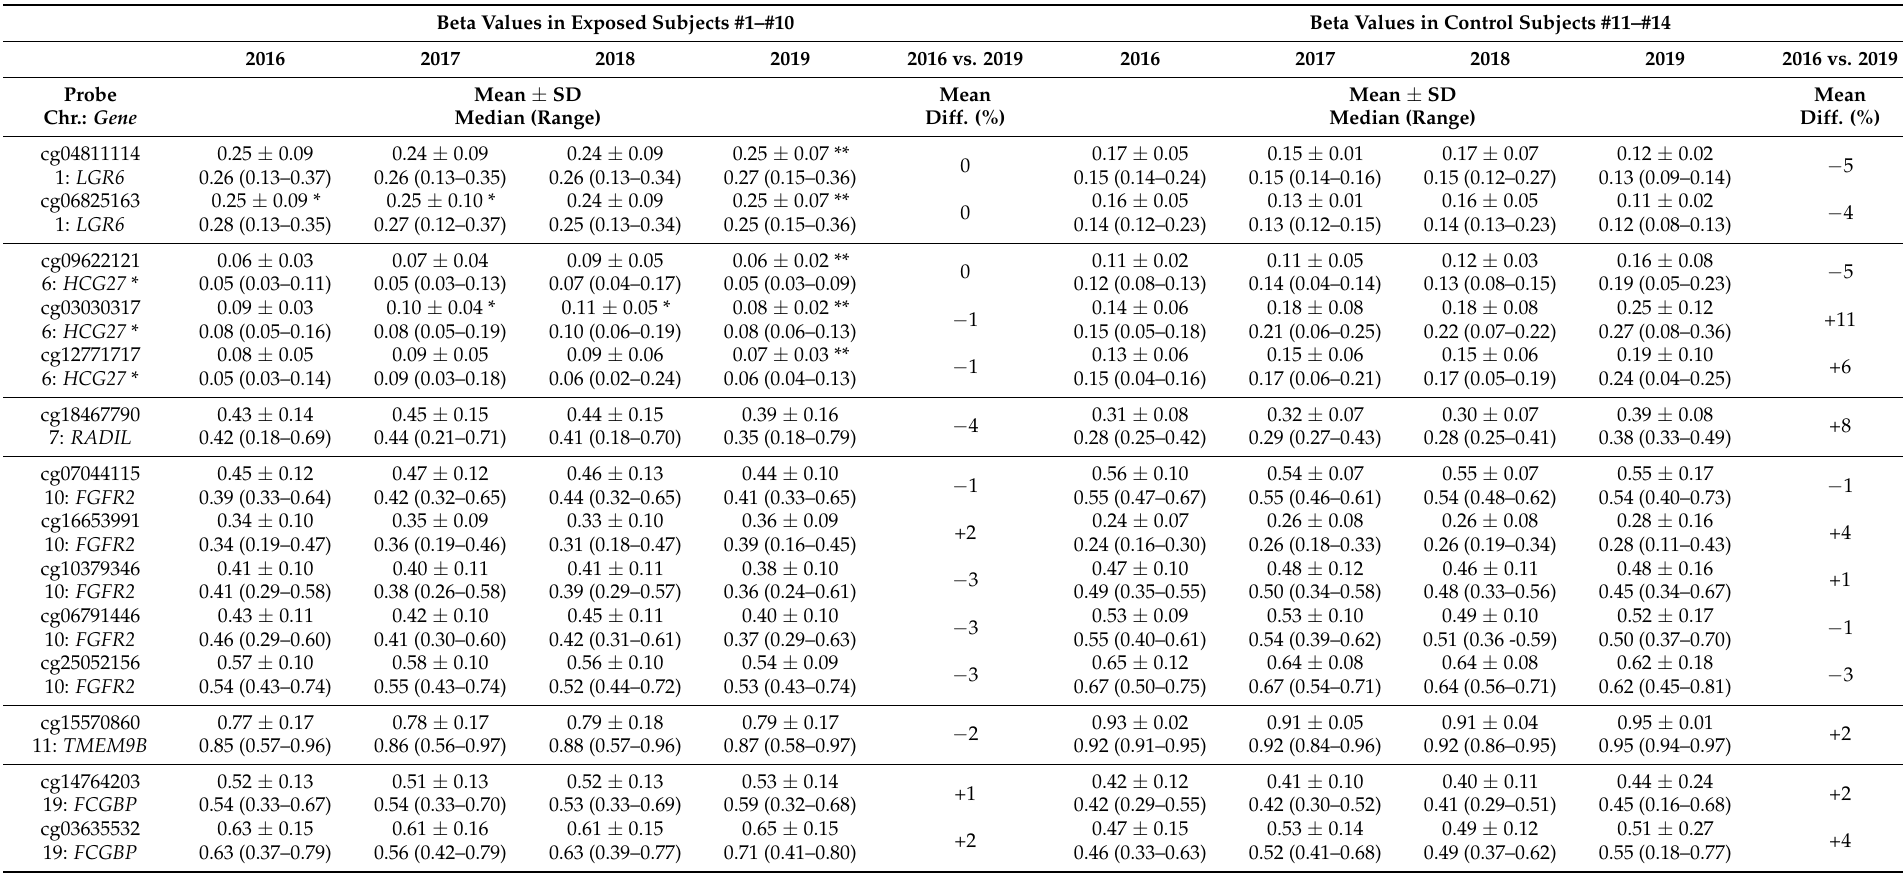
Abbreviations: LGR6, leucine-rich repeat-containing G; RADIL, Rap associating with DIL domain; FGFR2, fibroblast growth factor receptor 2; TMEM9B, TMEM9 domain family member B; FCGBP , Fc fragment of IgG binding protein; HCG27 *, HLA complex group 27 (* RNA gene); β value comparison between the exposed and control subjects: * p < 0.05 and ** p <